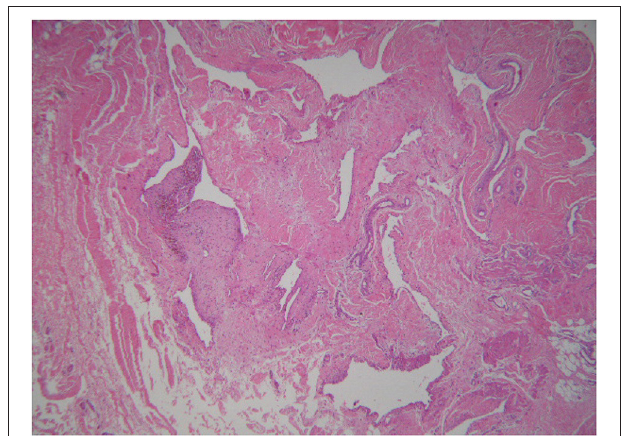
FIGURE 2 | Case 1: histology. Histological findings showing proliferation of arterial and venous vessels in a fibrous stromal tissue type (haematoxylin